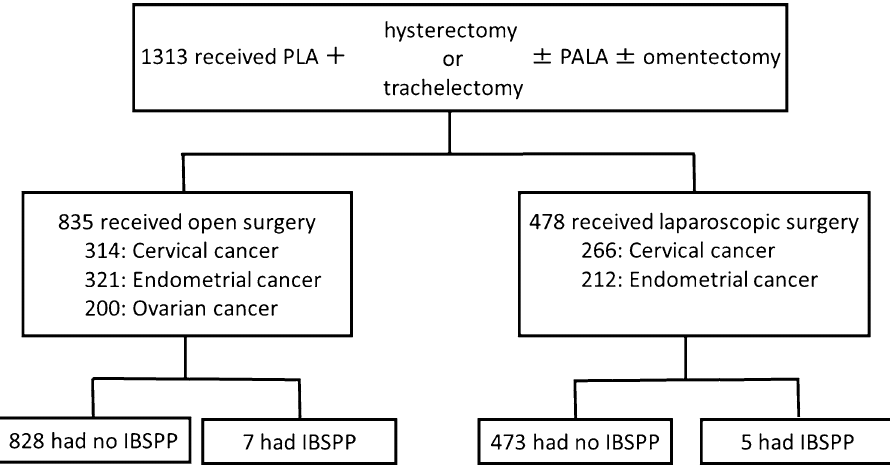
Figure 2. Flow chart of all patients’ contents. PLA, pelvic lymphadenectomy; PALA, para-aortic lymphadenectomy.